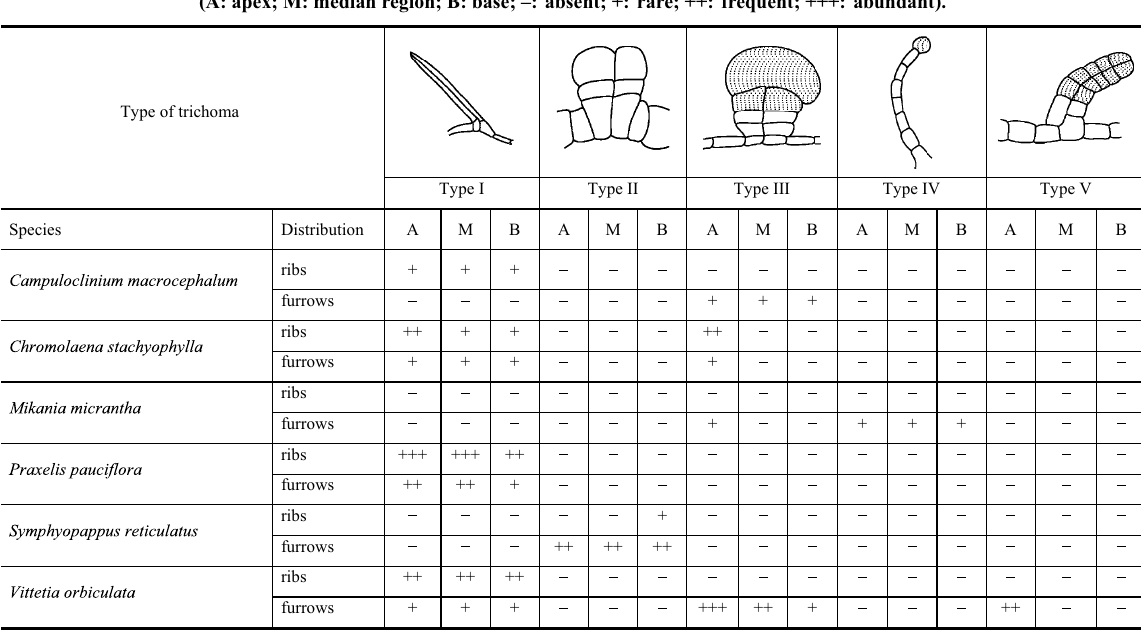
Types* and distribution of trichomes on the cypselae of the examined